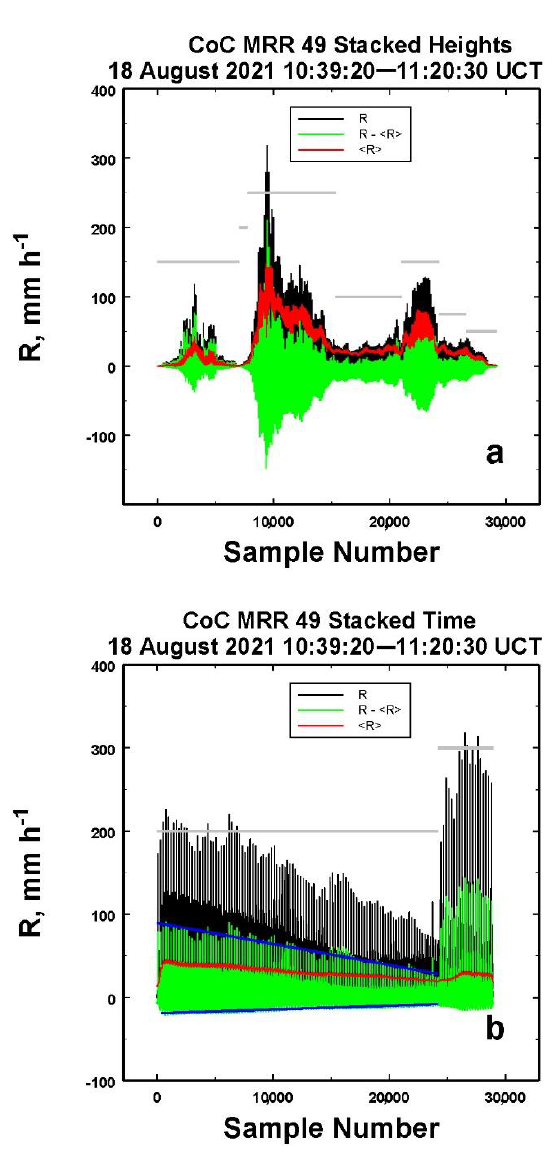
Figure 2. Data series constructed from: ( a ) stacking the sequential observations of height in Figure 1 into a single vector (black lines) with the computed mean curve (red) and fluctuations (green) and ( b ) from stacking sequential time observations over all time. As explained in the text, the grey lines denote the breakdown into regions for subsequent calculations of the statistical homogeneity IXH . In ( b ), the blue line indicates where the fluctuations are constantly changing.